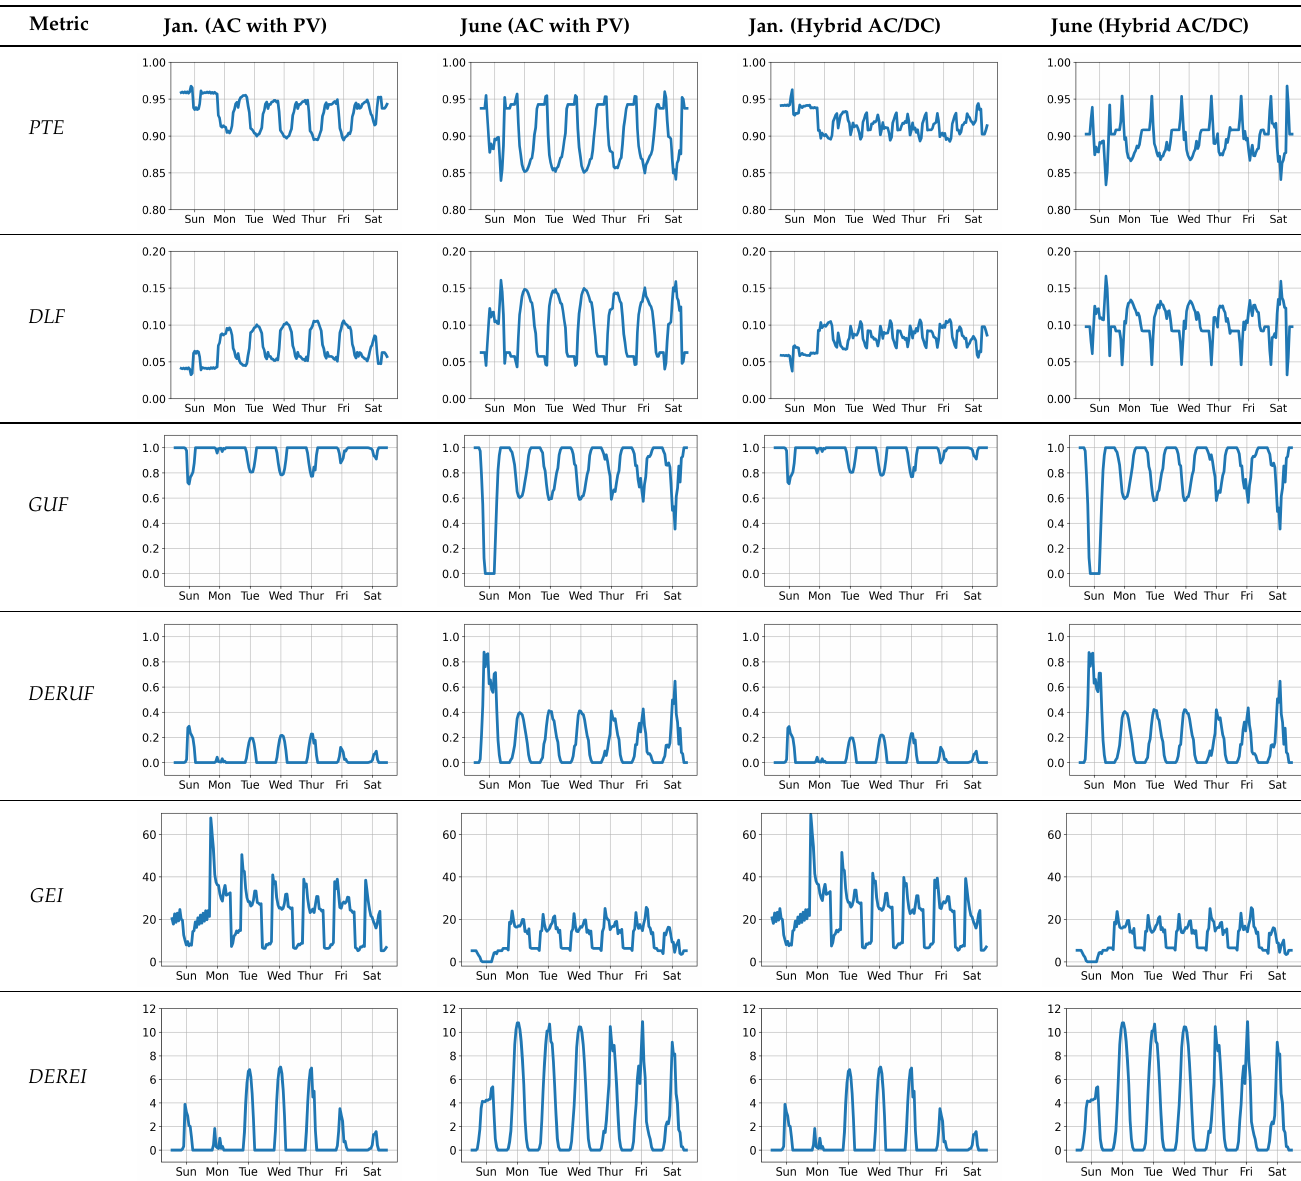
Table 3. Seasonal variation of metrics for the AC and hybrid building electrical distribution